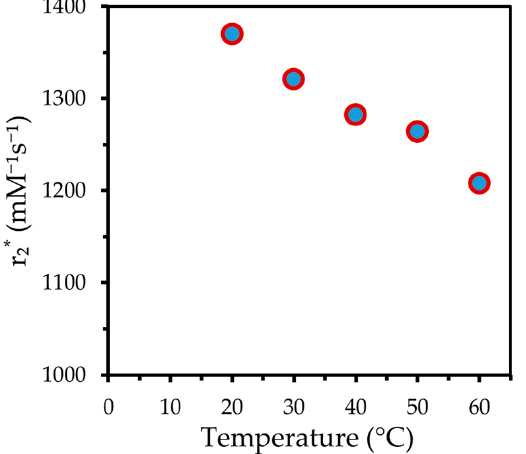
Figure 9. Temperature dependence of r 2 * relaxivity for protons in silicone doped with MnZn